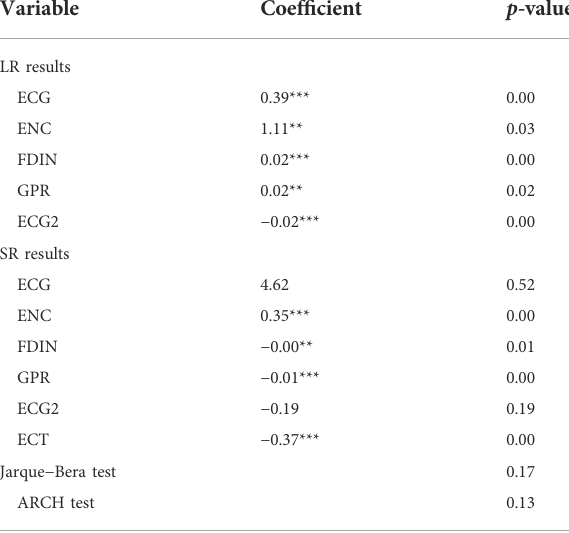
TABLE 7 Findings from PMG − ARDL for the full